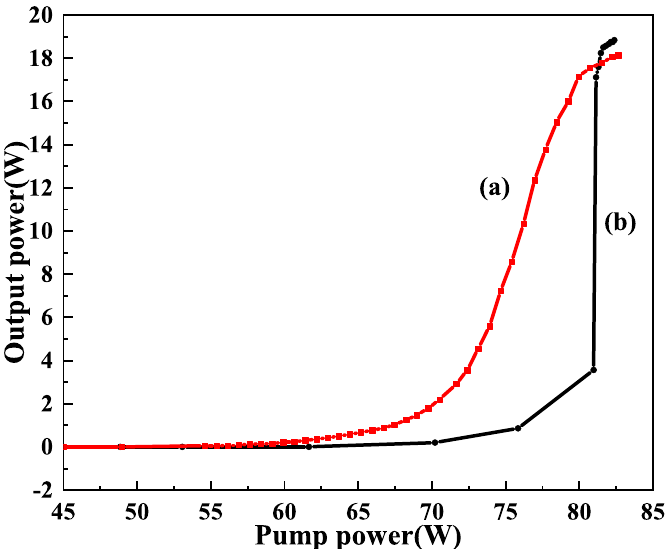
Figure 10. Output power of the 532 nm laser in the cases of increasing and decreasing the incident pump power without the bistability-like phenomenon. ( a ) The coupling mirror coated with the transmittance of 2% at fundamental-wave laser and ( b ) the coupling mirror coated with HR films at fundamental-wave